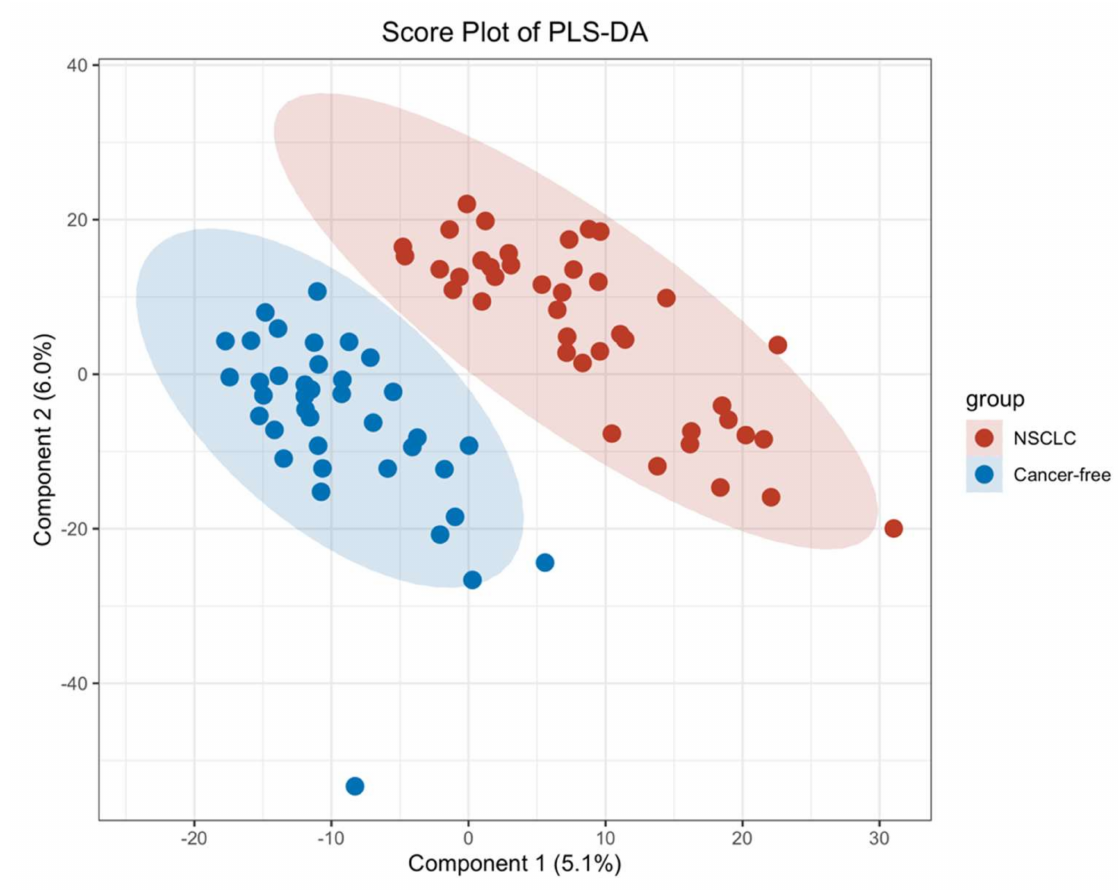
Figure 2. PLS–DA score plot between the NSCLC group and cancer-free control